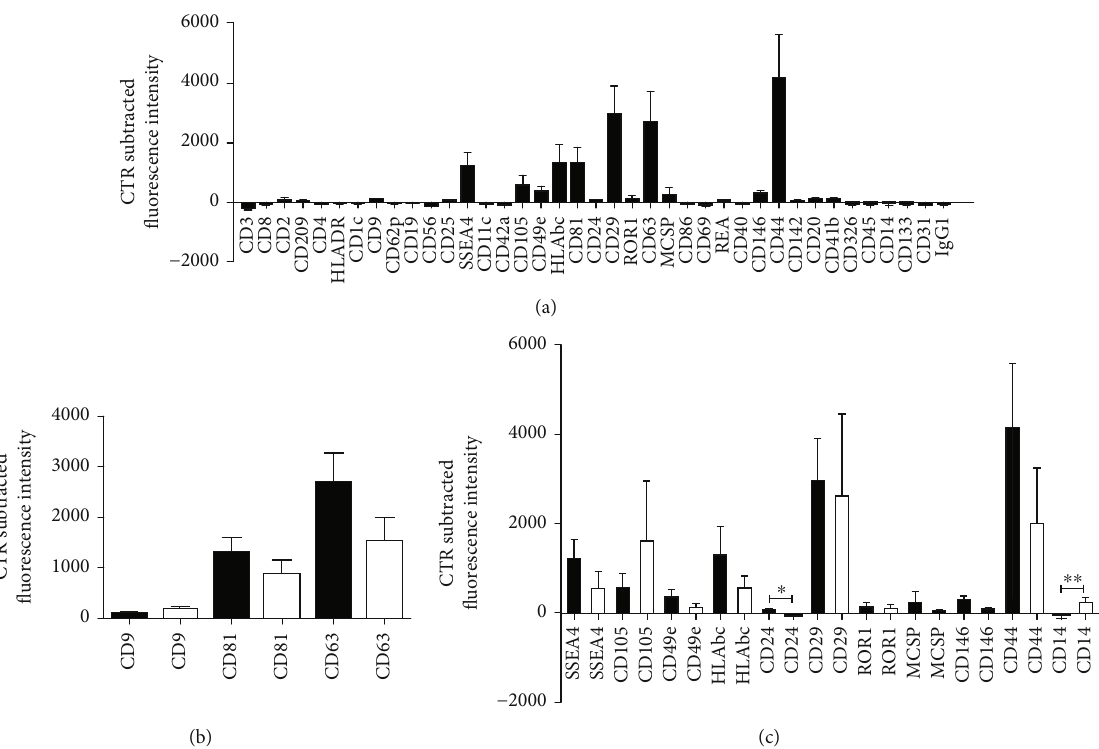
Figure 1: sEVs_IL-1 Surface Epitope characterization. (a) Whole MACSPlex Exosome Kit surface assessment of 37 surface markers and 2 isotype controls of di ff erent puri fi ed sEVs_IL-1 preparations ( n = 3 ) from IL-1 β treated ADSC (black graphs). Data are expressed as net fl uorescence intensity (control subtracted fl uorescence intensity) and displayed as mean ± SD . (b) Side-by-side comparison of the expression of tetraspanins (CD9, CD81, and CD63) in sEVs obtained from IL-1 β treated ADSC (sEVs_IL-1, n = 3 , black graphs) or untreated ADSC (sEVs, n = 3 , white graphs). (c) Side-by-side comparison of the expression of other 11 detectable surface markers in sEVs obtained from IL-1 β treated ADSC (sEVs_IL-1, n = 3 , black graphs) or untreated ADSC (sEVs, n = 3 , white graphs). The latter correspond to data presented in [5]. Since the ADSC cultures were the same, comparisons were undertaken by mean of the Student ’ s t - test for paired samples and statistically signi fi cant di ff erences evidenced as ∗ p < 0 : 05 and ∗∗ p < 0 : 01